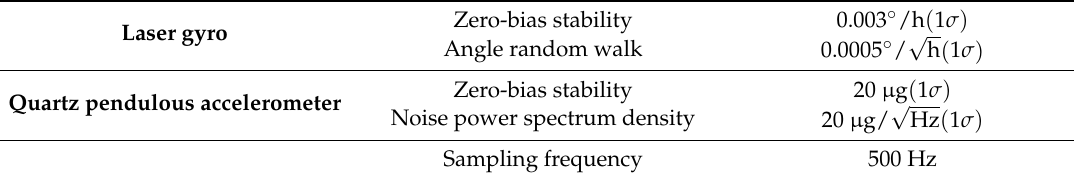
Figure 4. The experimental environment. Table 3. Main parameters of inertial devices.